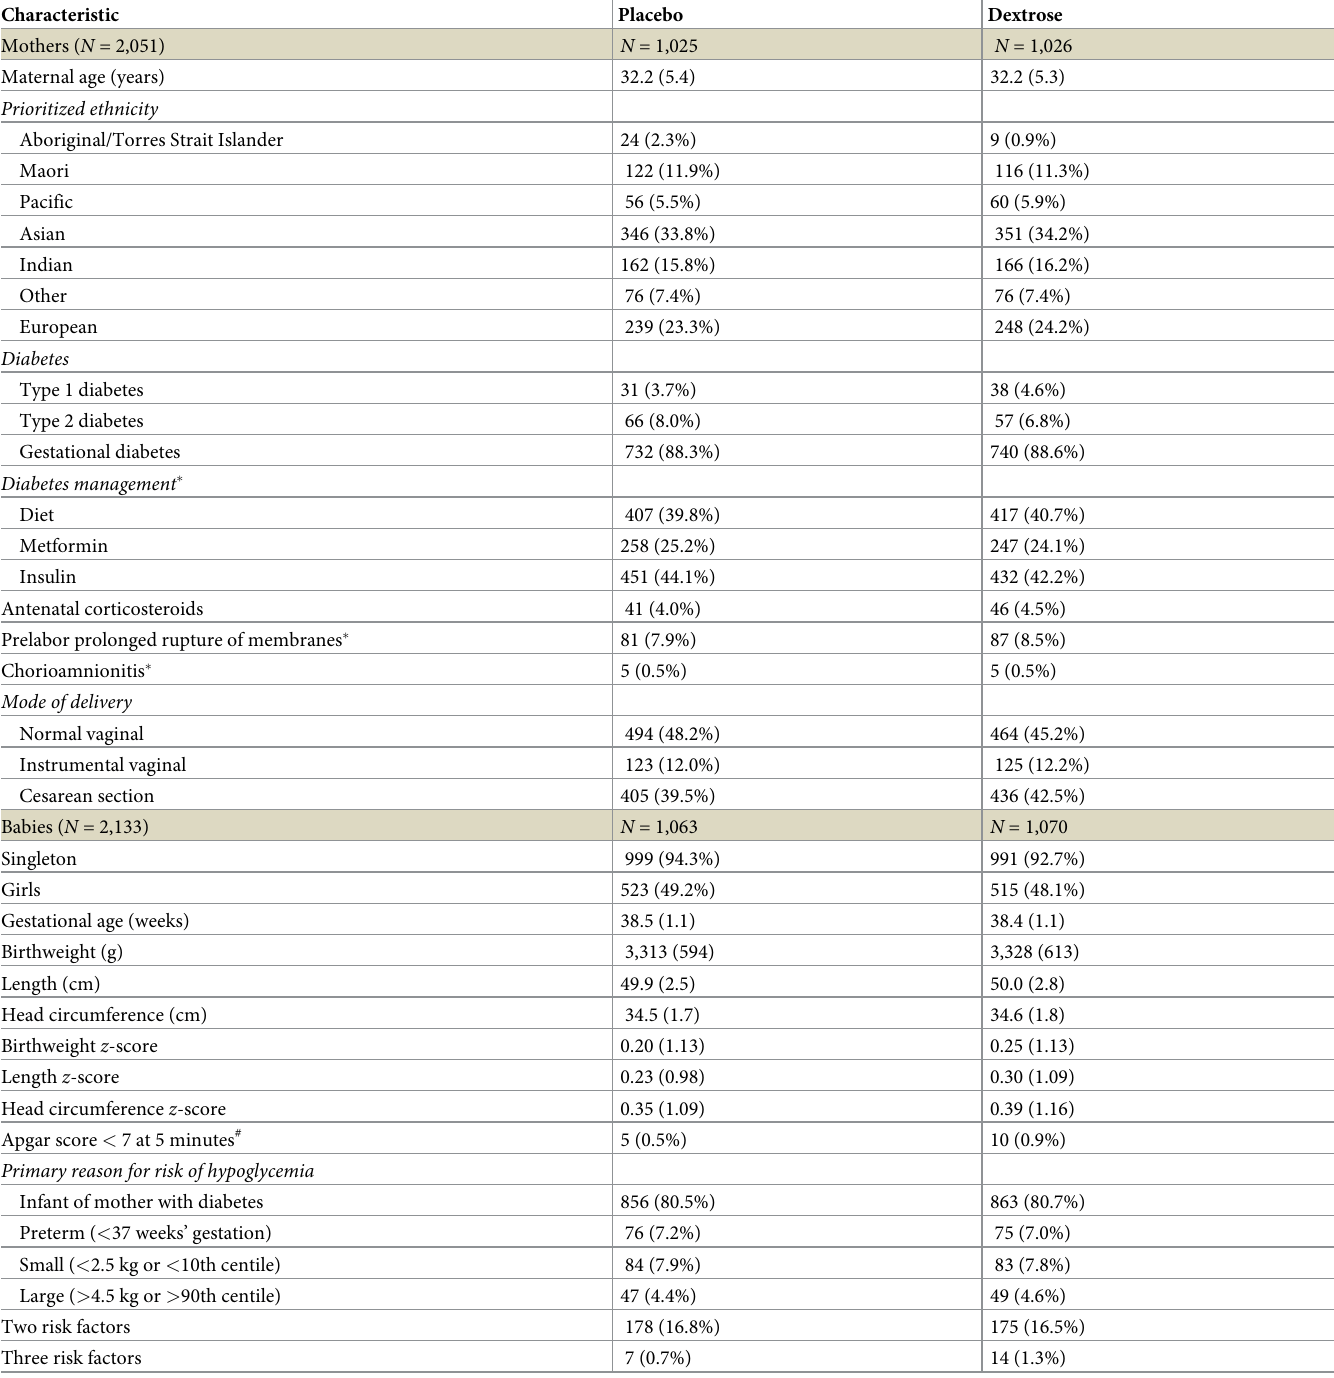
Table 1. Characteristics of mothers and babies randomized to placebo or dextrose